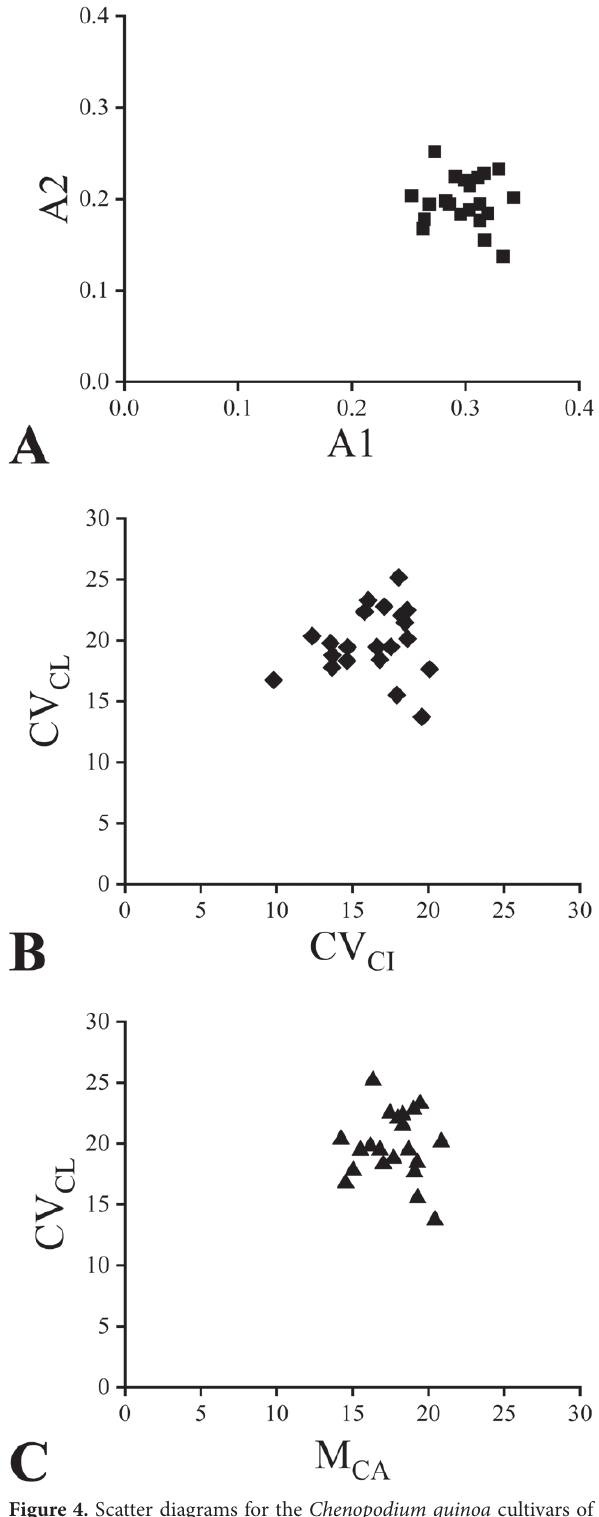
Figure 4. Scatter diagrams for the Chenopodium quinoa cultivars of (A) A1 against A2 (B) CV CI against CV CL (C) M CA against CV CL